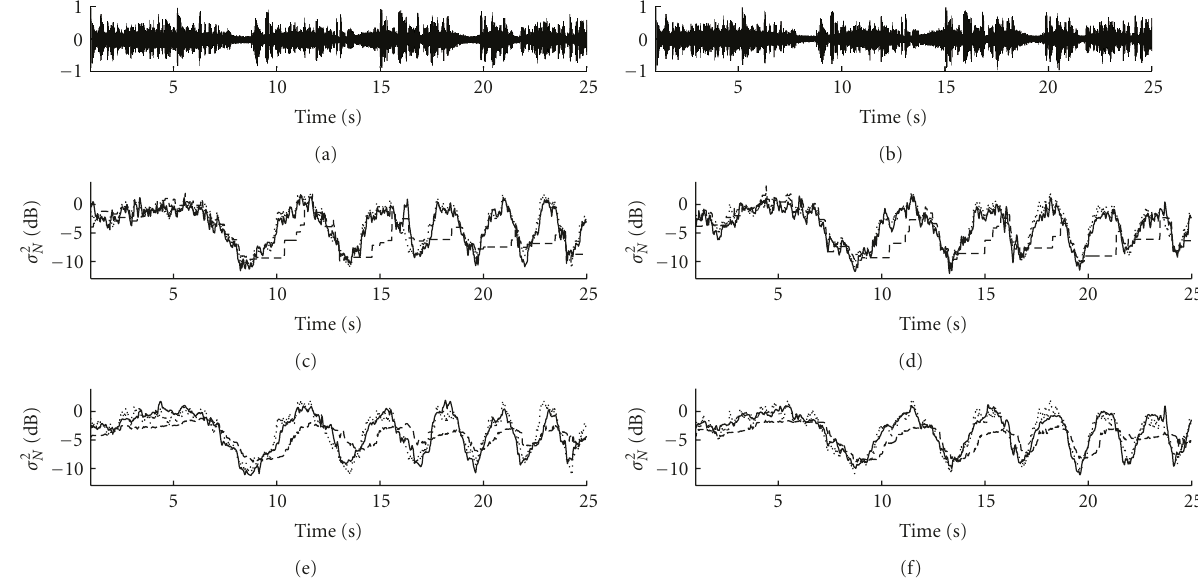
Figure 6: Comparison between estimated noise PSD and the true noise PSD. (a)-(b) Speech signal degraded by modulated white noise at an overall SNR of 5 dB. (c)-(d) Comparison between true noise PSD (dotted line), proposed approach (solid line), and MS (dashed line) for DFT bin centered around (c) 0.9 kHz and (d) 2.0 kHz. (e)-(f) Comparison between true noise PSD (dotted line), DFT-subspace approach (solid line), and QB approach (dashed line) for DFT bin centered around (e) 0.9kHz and (f) 2.0kHz.